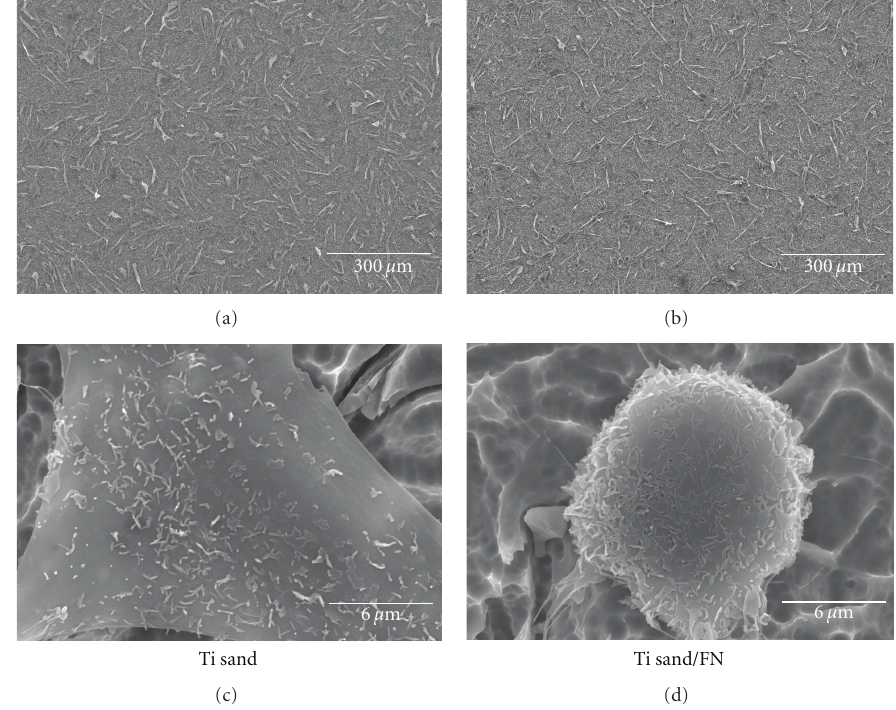
Figure 5: SEM views of MC3T3-E1 cells cultured on Ti sand and Ti sand/FN titanium disk at 1 day of culture.